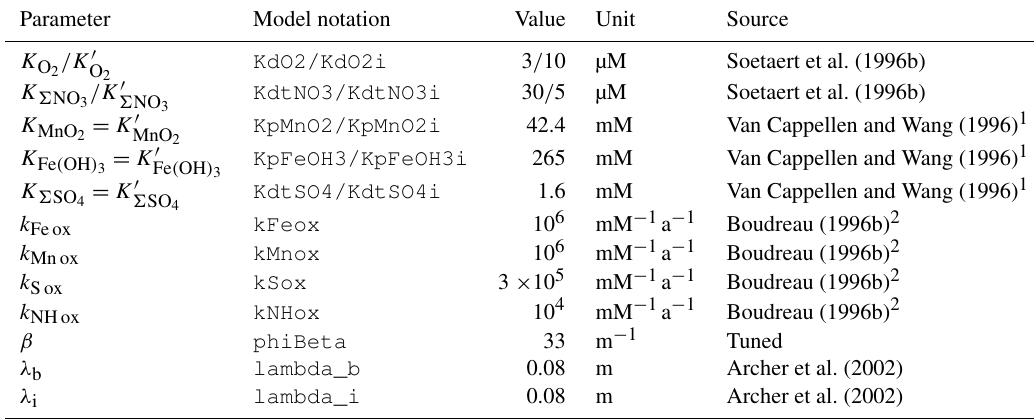
Table 4. Suggested values for model parameters. Parameter Model notation Value Unit Source KdO2/KdO2i 3 / 10 µM Soetaert et al. (1996b) /K (cid:48) K O O 2 2